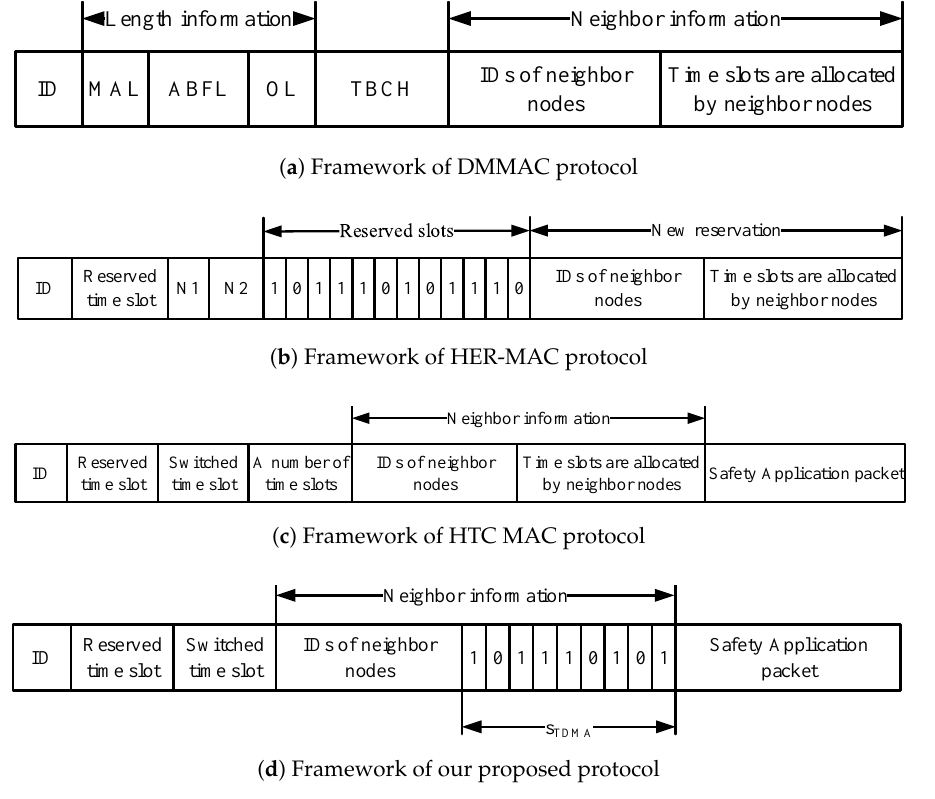
Figure 2. Comparison of frameworks used in hybrid MAC